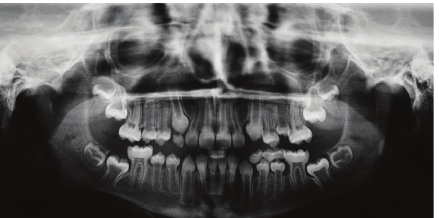
Figure 4: Panoramic radiography showing large pulp chambers in all teeth, and absence of agenesis, impaction, or supernumerary